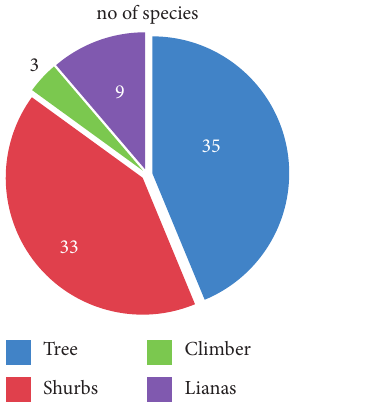
Figure 2: Growth form of woody